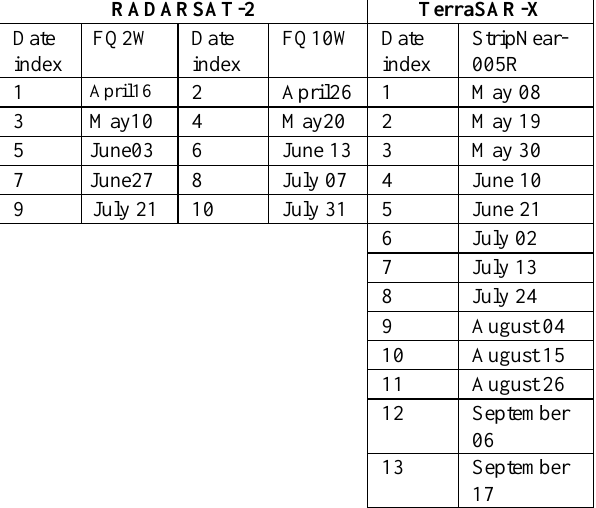
Table 1. RADARSAT-2 and TerraSAR-X Data